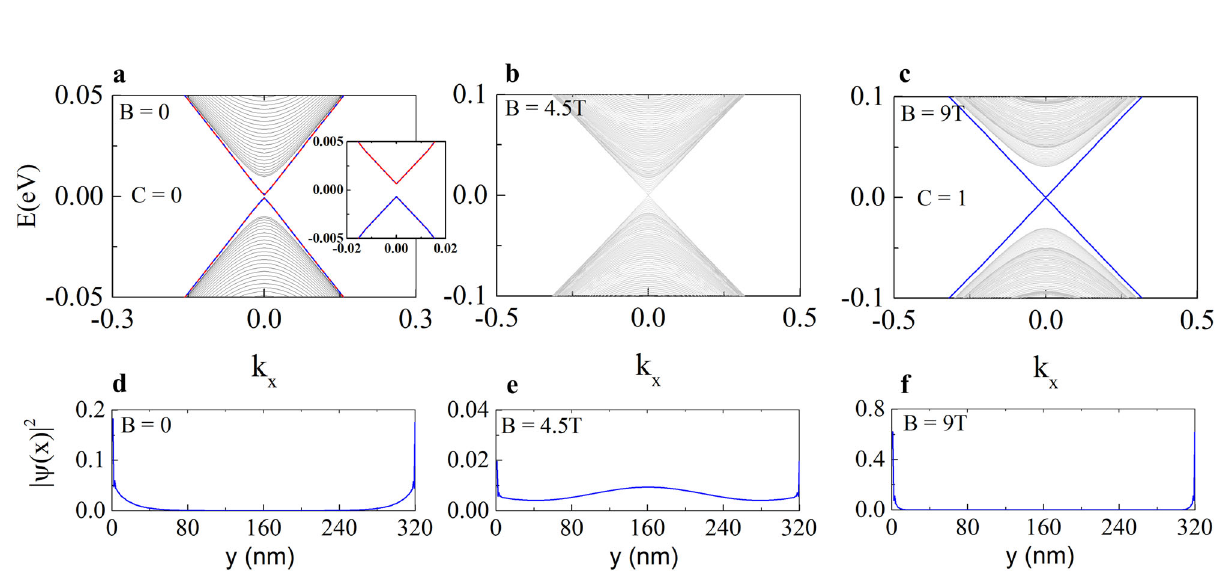
Fig. 4 | Effective model calculations. a – c Evolution of band structures of 6-SL MnBi 2 Te 4 bysweepingthemagnetic fi eld B .Thered(blue)lineindicatesthehelical (chiral) edge mode. The system employs a periodic boundary condition in the x direction and an open boundary conditions in the y direction. d – f Spatial